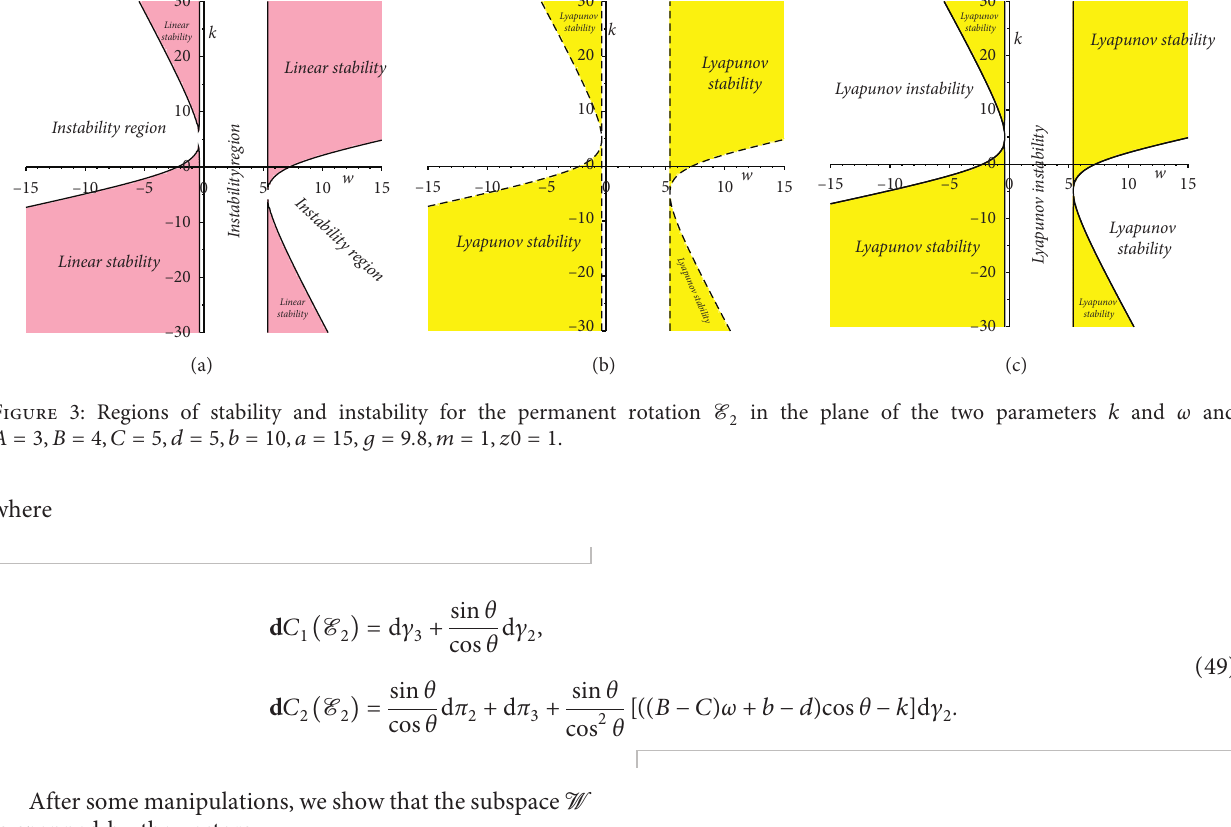
Figure 2: Regions of stability and instability for the permanent rotation E + A � 3 , B � 4 , C � 5 , d � 5 , b � 10 , a � 15 , g � 9 . 8 , m � 1 , z 0 �